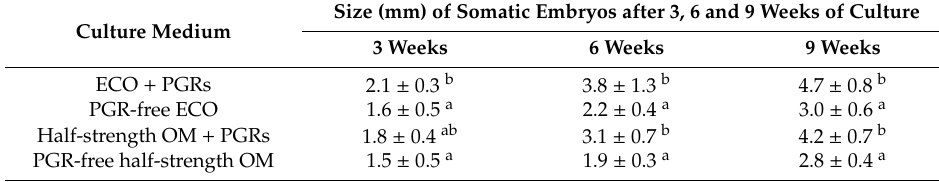
Data are means ± standard deviation. Data in the same column followed by di ff erent letters are significantly di ff erent. ECO, olive cyclic embryogenesis medium; OM, olive medium; PGR, plant growth regulator: 0.1 mg L −